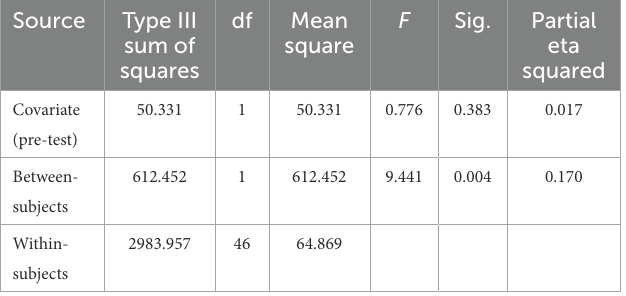
TABLE 2 ANCOVA results for writing skill.